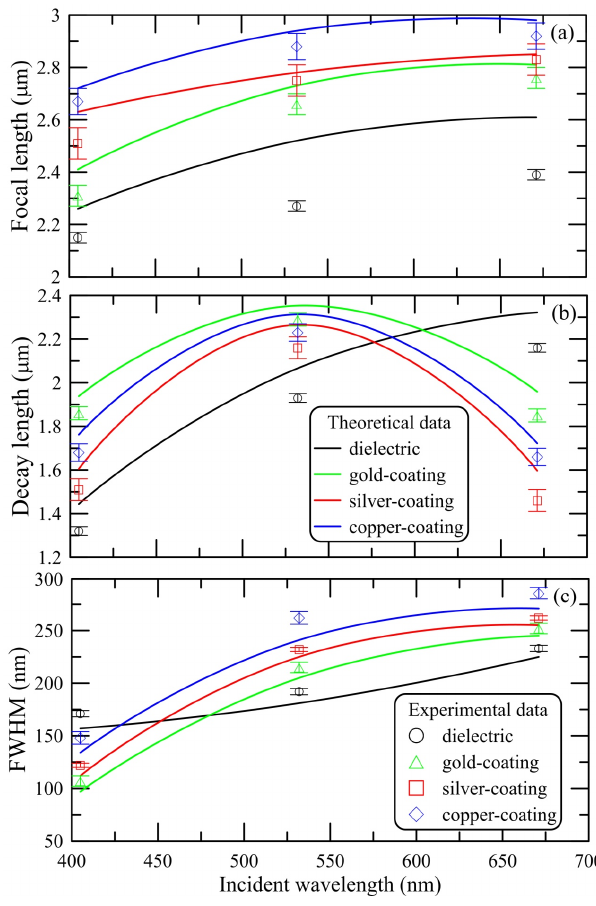
Figure 3. Critical parameters as a function of incident wavelength for the dome microlenses with different metal coatings: ( a ) focal length, ( b ) decay length, and ( c ) FWHM.